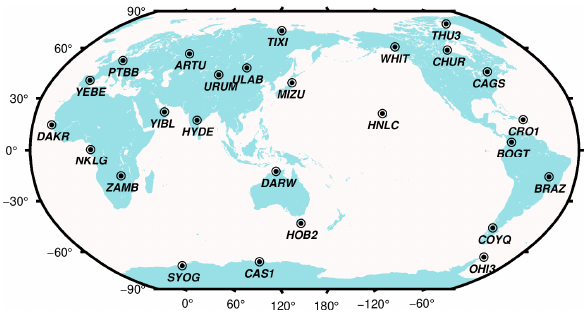
Figure 1. Global distribution of 26 selected IGS and NGL common stations.